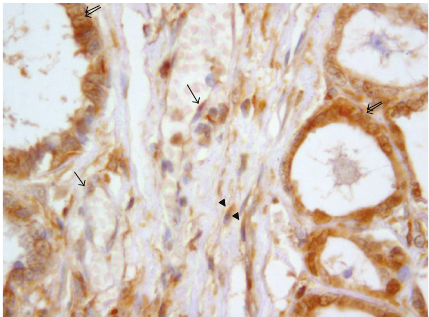
Figure 3: Figure 3: Dog. Mammary tumor. Cytoplasmic endothelial (arrow) positivity of vessel walls, of stromal fibroblasts (arrowhead), and of carcinoma cells (double arrows). Anti-VEGF immunohisto- chemistry